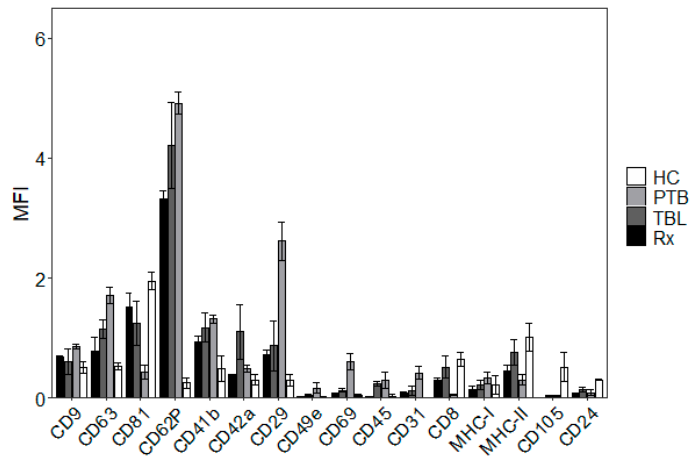
Figure 2. Flow cytometric MACSPlex exosome kit analysis of exosome surface protein markers. The x-axis represents selected proteins, whereas the y-axis shows the normalized APC-MFI. The median APC-signal intensity of each specific population of single beads was normalized to the average of the anti-CD9, anti-CD63, and anti-CD81 beads. MFI, median fluorescence intensity. Data sets are presented as mean ± SEM ( n = 3). Complete data of all analyzed surface markers is provided in Table S2.